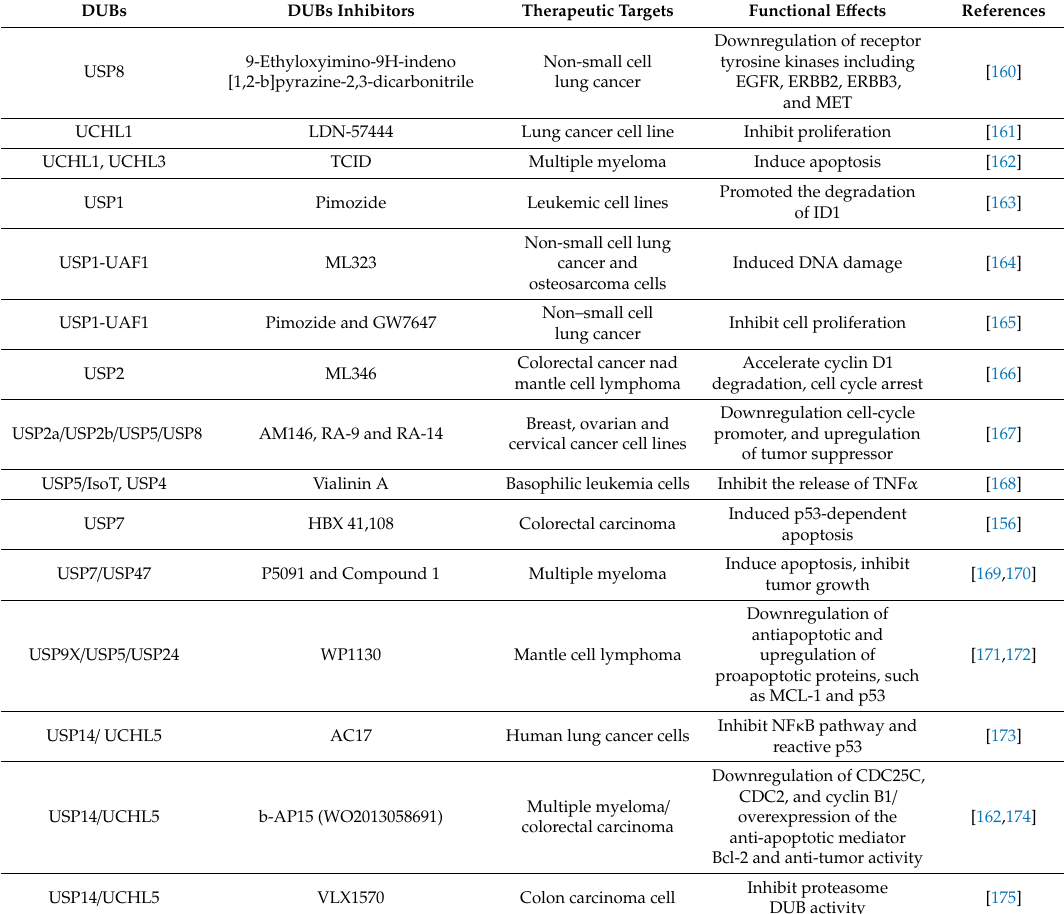
Table 3. Summary of known DUB inhibitors that are targeted in cancer